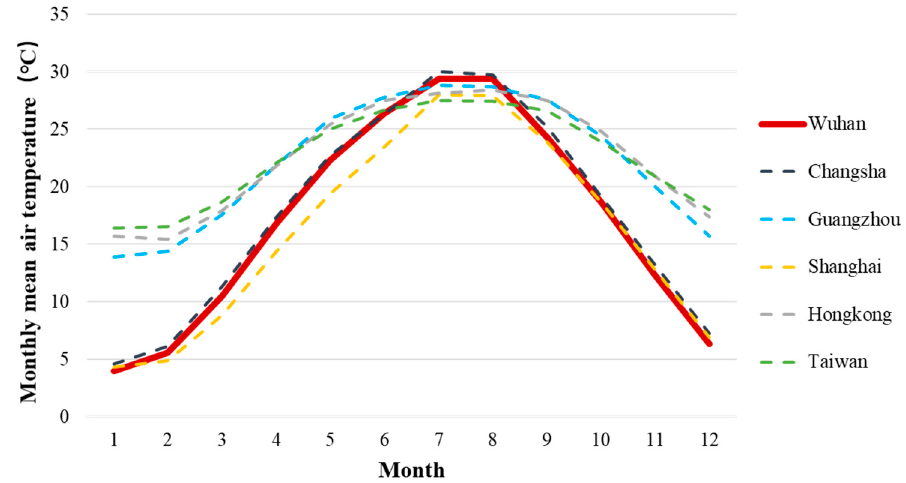
Figure 11. Monthly mean air temperature of several large cities in China, as reported in this and previous studies